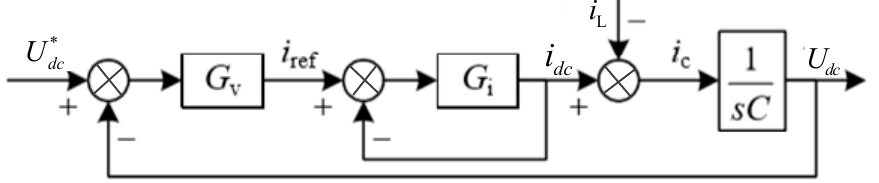
Figure 4. Double closed loop control block diagram based on PI controller.